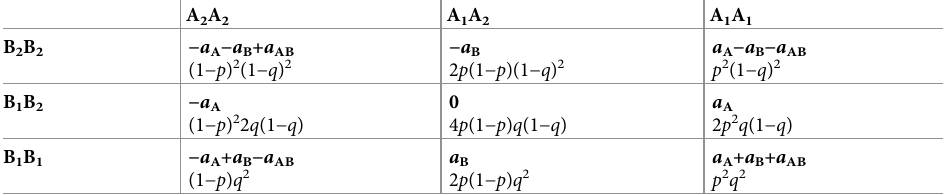
Table 1. Genotypic values and frequencies of a 2-locus model with additive and additive-by-additive effect and no dominance at either